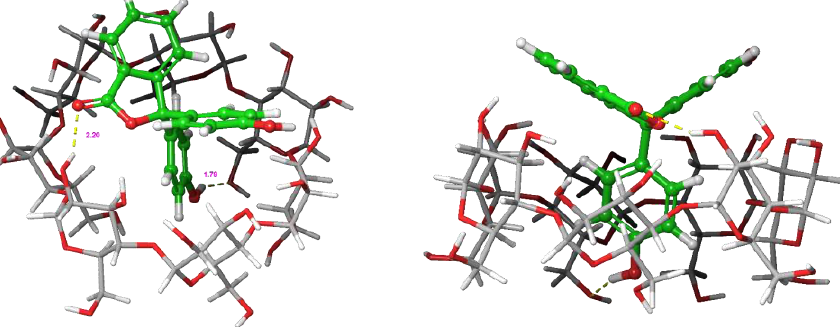
Figure 6. Two different views of the inclusion complex structure as obtained from molecular docking analysis.